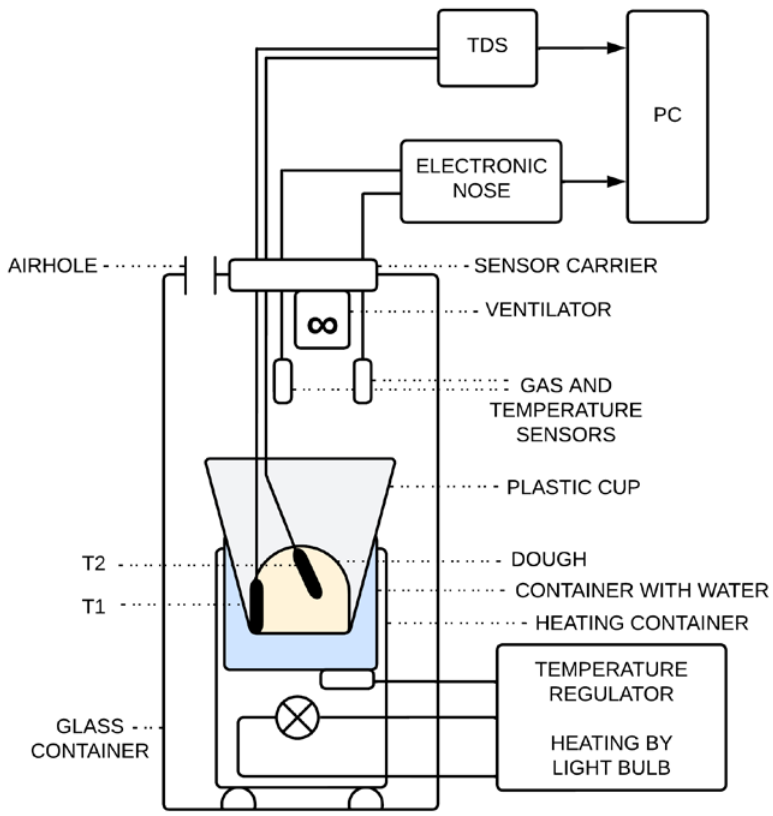
Figure 3. The schematic diagram of the fermentation measurement of various flour mixtures using thermodynamic sensors.